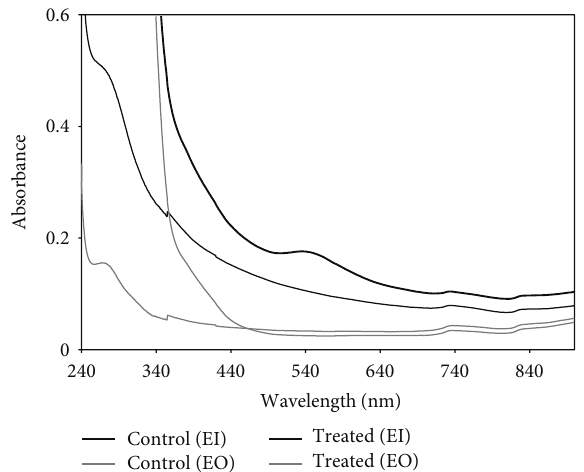
Figure 7: UV-Vis spectra showing GNP biosynthesis in the dialyzed ECF extracts.